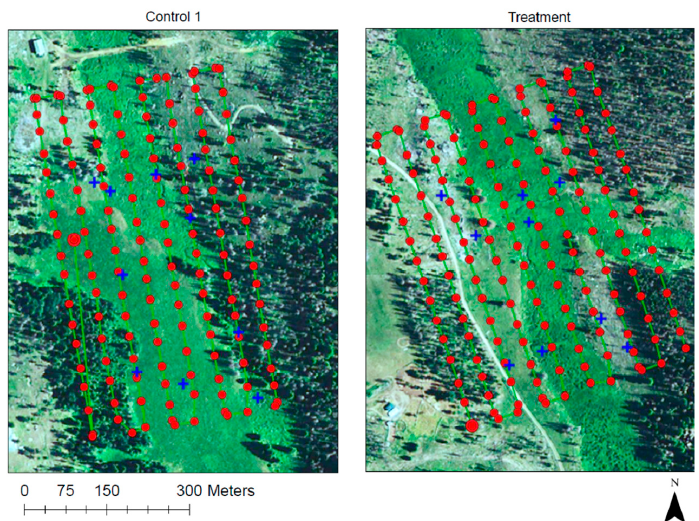
Figure 5. sUAS flight paths. Red dots represent individual captures and blue crosshairs represent geolocated ground control points and check points. Left: Control 1 reach. Right: Treatment reach.